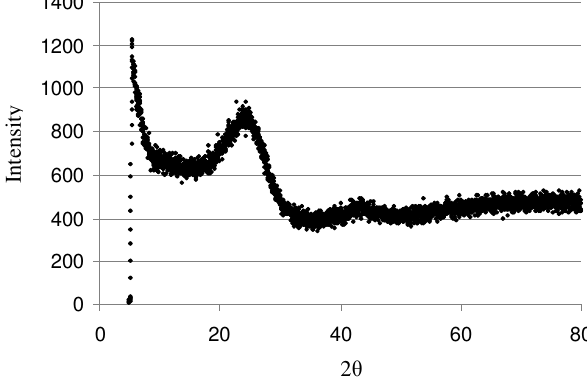
Figure 4. X-ray diffractogram of sample